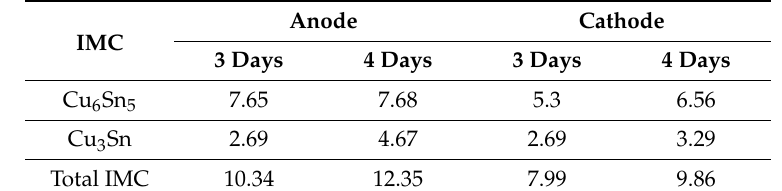
Table 4. The IMC formation and their corresponding thickness in the sample heated at 180 °C and subjected to a current of 0.8 A for the 5:5 sample.